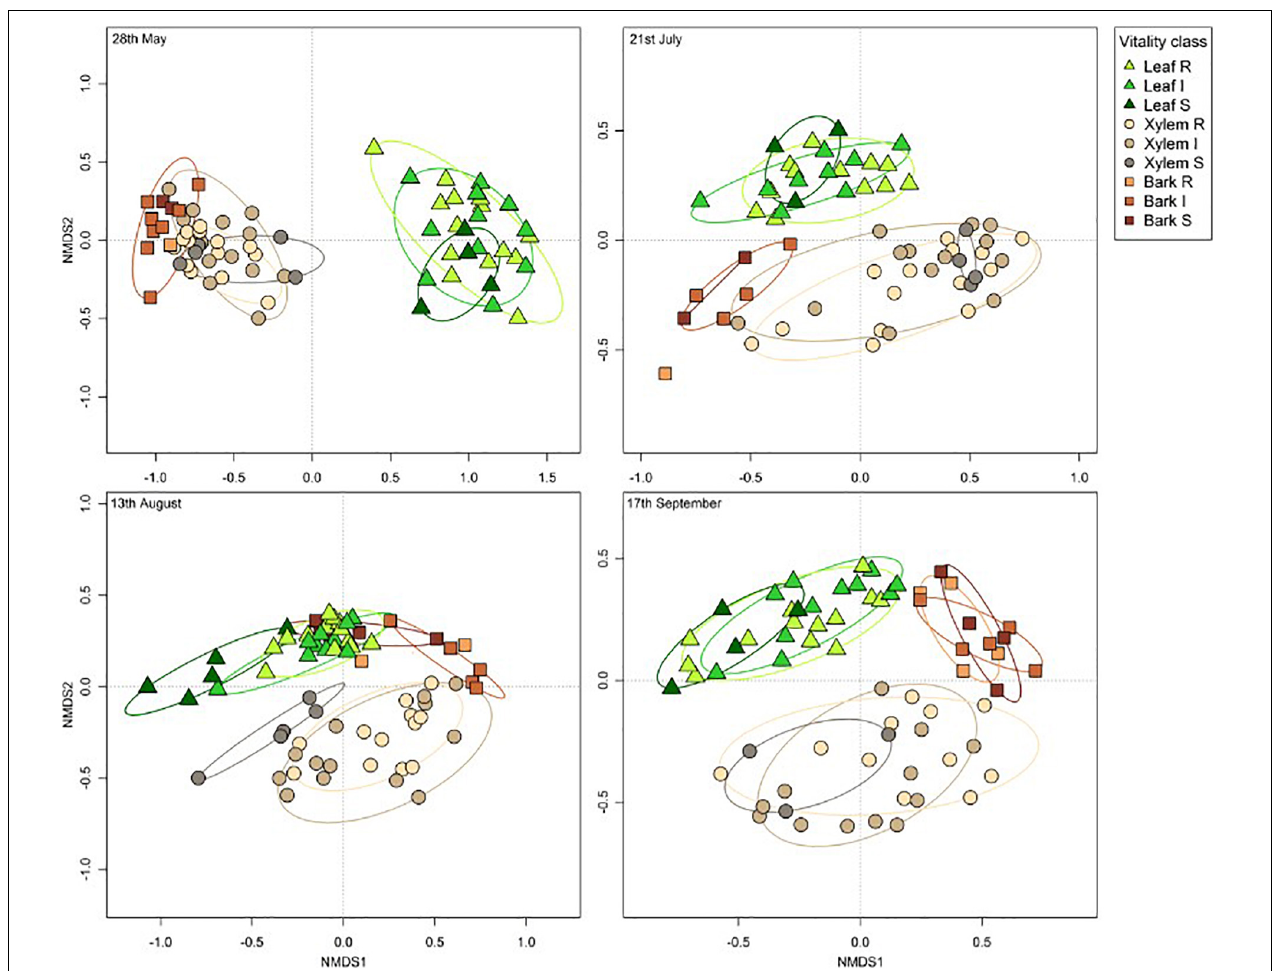
FIGURE 2 | Non-metric multidimensional scaling (NMDS) ordination plots of ash fungal communities based on Bray-Curtis dissimilarity matrix. The plots are divided according to the four sampling time points: 28th May (stress value = 0.08), 21st July (stress value = 0.12), 13th August (stress value = 0.13), and 17th September (stress value = 0.14). Tissue types are represented by different shapes (leaf: triangle, xylem: circle, bark: square). Susceptibility classes are represented by intensity of colors for the gradient from Resistant (light) to Susceptible